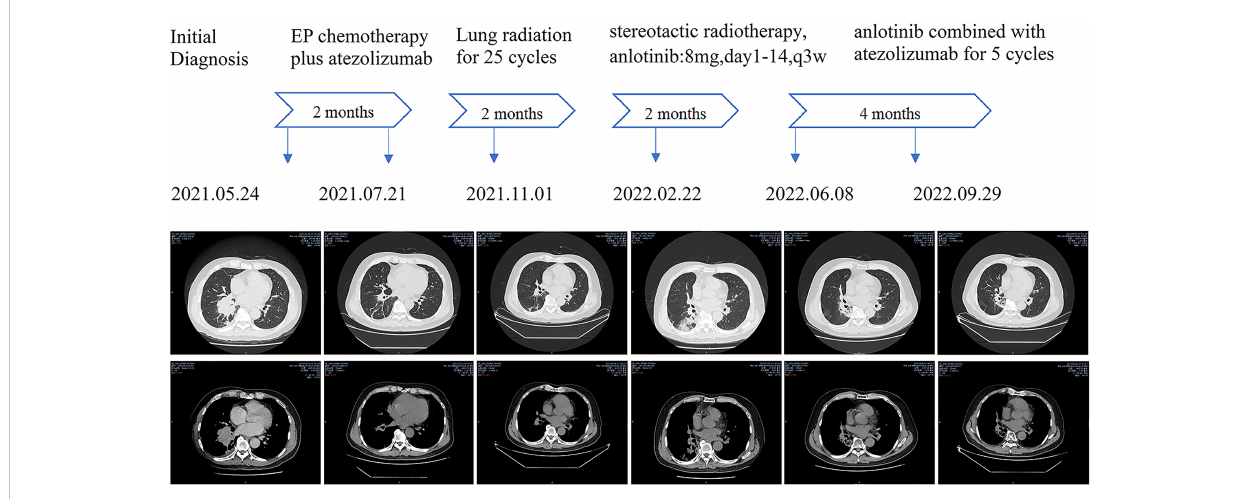
FIGURE 1 Chest CT images of primary lung noules at different time